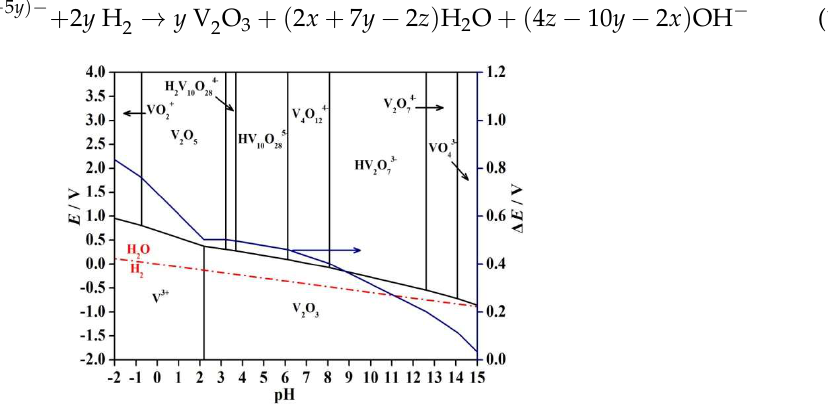
Figure 1. Potential–pH diagram for V–H 2 O system (only includes V (V) and V (III) species) at 298 K with activities of dissolved vanadium of 1 mol/L and H 2 partial pressure of 1 atm.